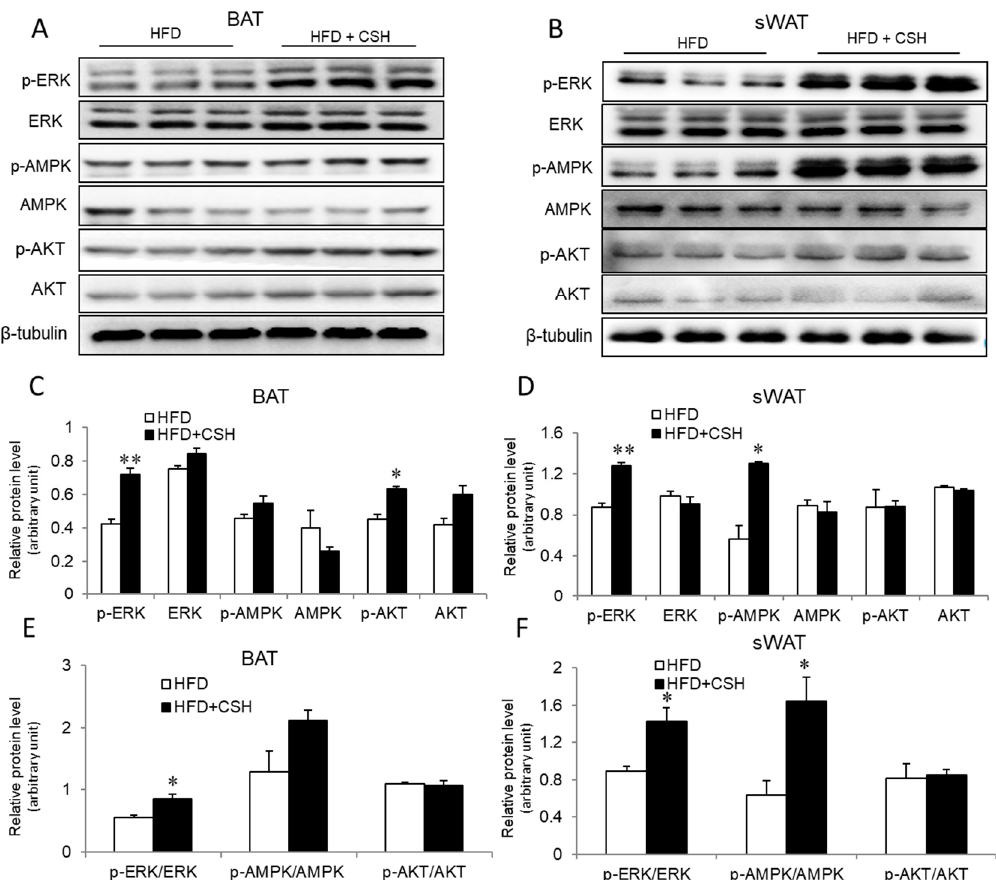
Figure 6. The expression levels of proteins involved in insulin signaling were analyzed after WECS treatment. The phosphorylation of MAPK was significantly increased after the WECS treatment in BAT and sWAT ( A , B ). The relative protein level of A and B were shown in ( C , D ). The relative protein level of p-ERK / ERK, p-AMPK / AMPK, p-AKT / AKT were showed in ( E , F ). Bars represent the mean + SEM, n = 3. * p < 0.05, ** p < 0.01 compared with the HFD control group.